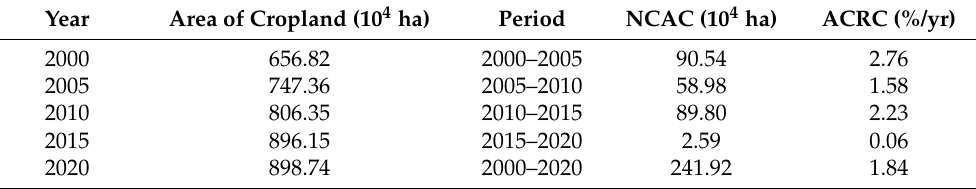
Table 4. Change characteristics of cropland quantity in Xinjiang during 2000–2020.